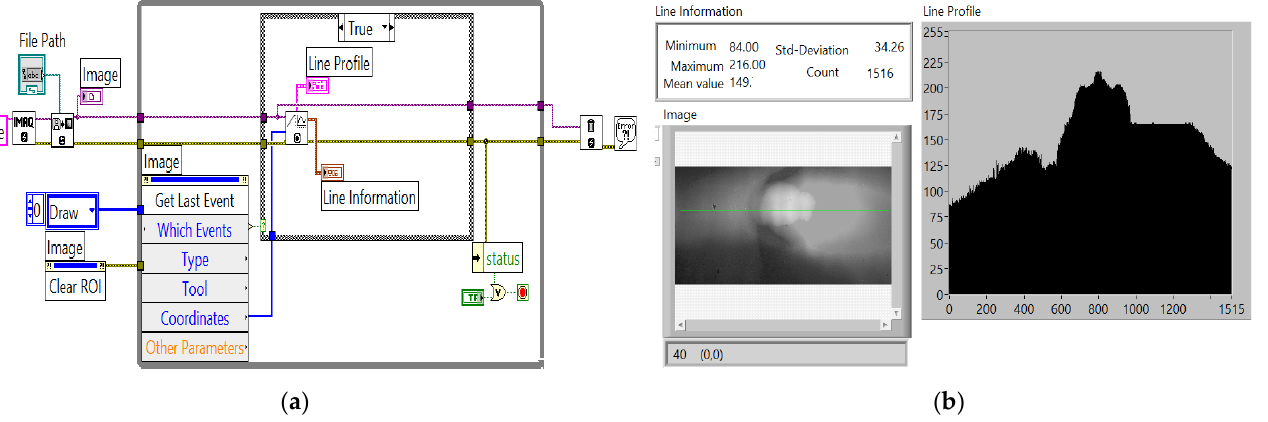
Figure 4. ( a ) Block diagram for the line information on pixels. ( b ) Green line is drawn on the image to observe the line graph.